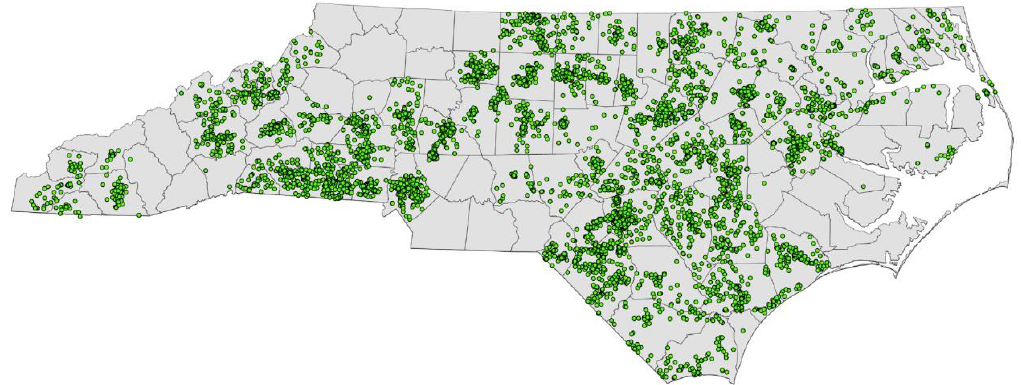
Figure 4. Geographical distribution of participants enrolled in the ZOE 2.0 study across the state of North Carolina, United